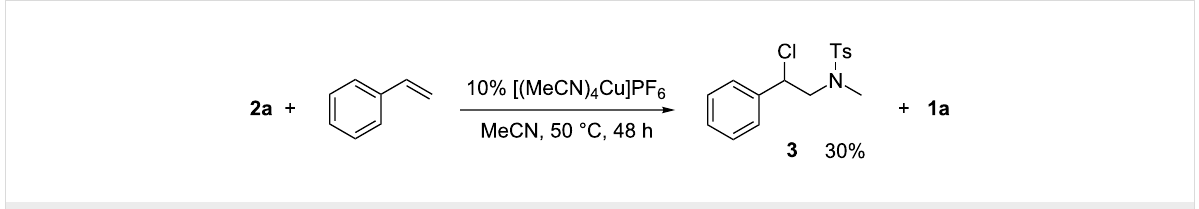
Scheme 2: First experiments for the intermolecular radical addition.